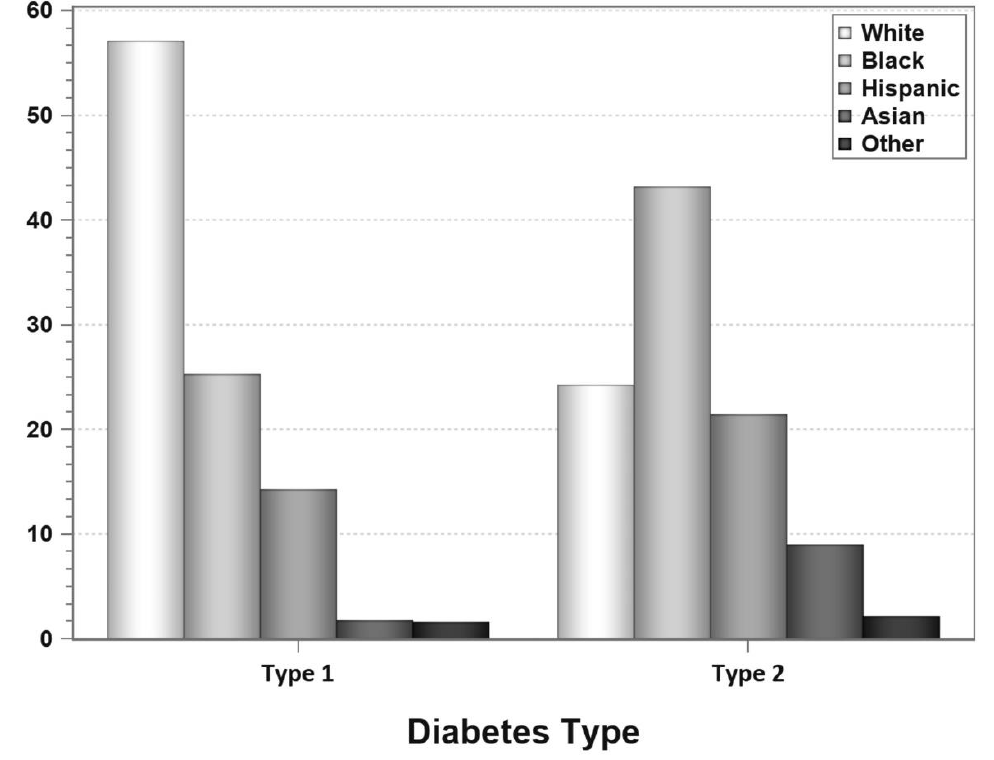
Figure 4. Proportion of SPKT recipients by race according to diabetes type in the latest era (1